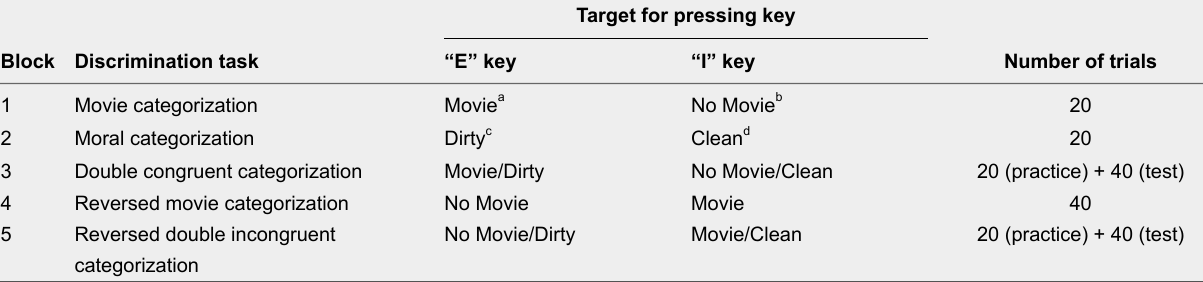
Summary IAT Blocks and